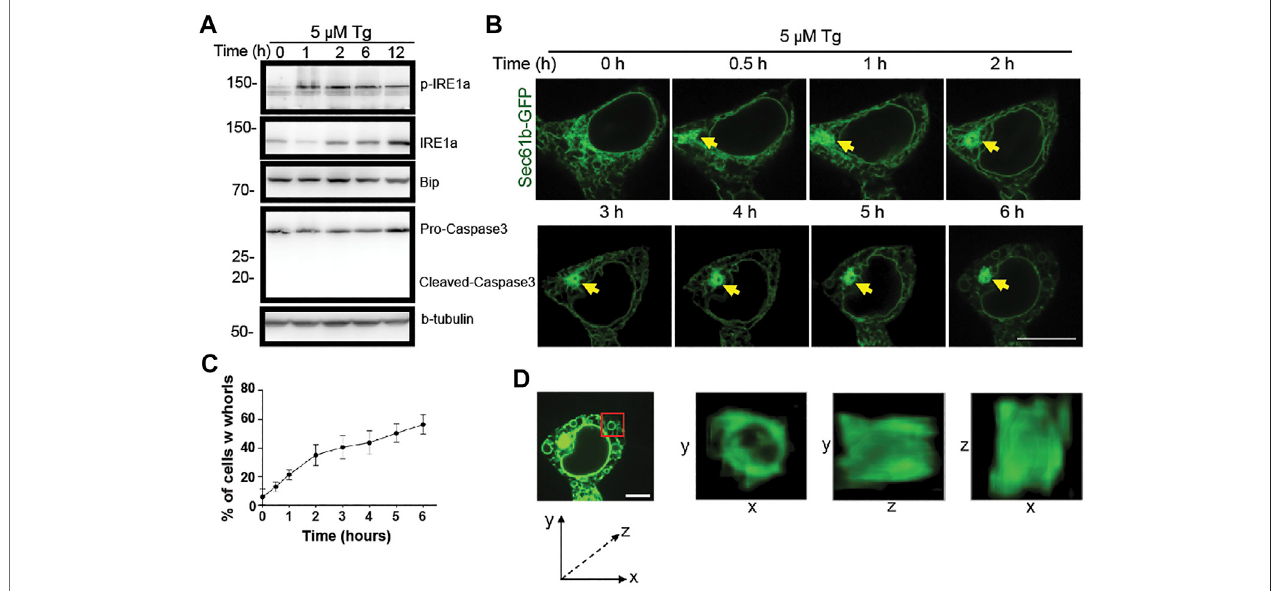
FIGURE2| Progressive changesofER structure under ERstressover time. (A) Immunoblotanalysisofp-IRE1 α , IRE1 α ,caspase3 (proand cleaved)and β -tubulin fromcelllysatesaftertreatmentofHEK293TcellswithDMSOor5 μ M Tgfortheindicateddurations. (B) RepresentativeERstructureslabeledwithGFP-Sec61 β (green) inHEK293Tcellstreatedwith5 μ M Tgfortheindicateddurations.YellowarrowspointtowhereinitialformationandevolutionofanERwhorloccur.Scalebar:20 μ m. (C) PercentagesofHEK293TcellswithERwhorlsaftertreatmentwith5 μ M Tgfortheindicateddurations.Datawerepresentedasmean ± SDfromthreeindependent experiments. (D) 5 × magni fi ed 3D views of the ring-like ER whorl in the region marked by the red box in the leftmost sub-panel. Scale bar: 10 μ m.